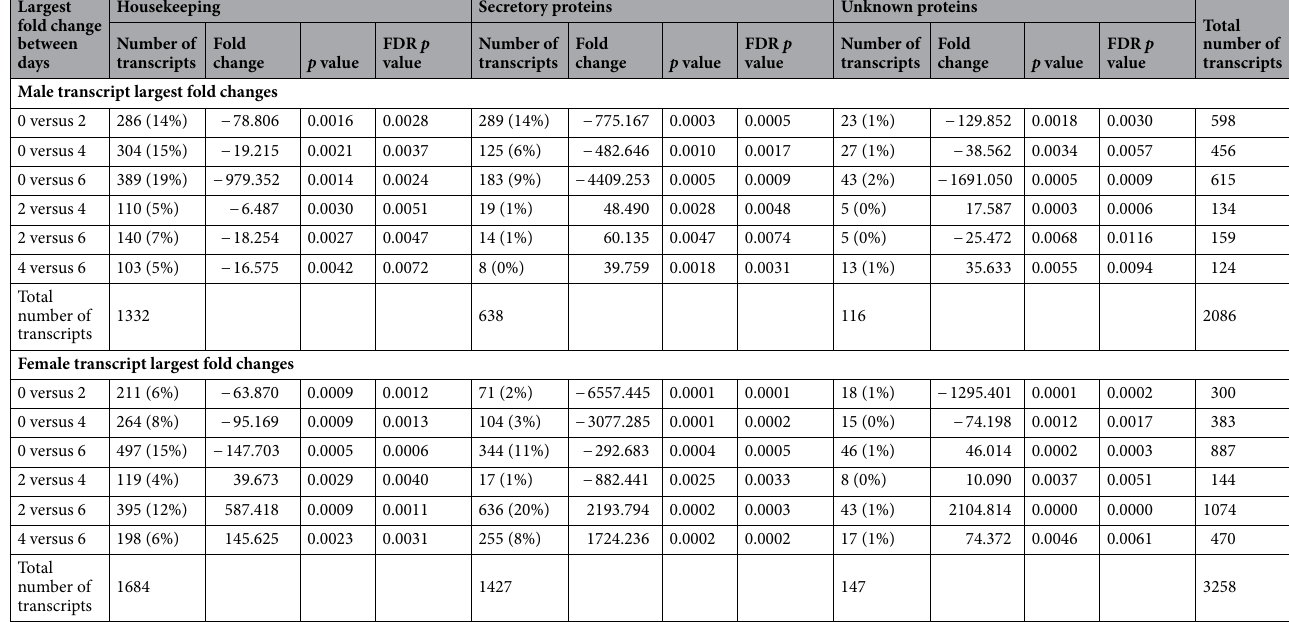
Table 3. Counts of transcripts of each class; housekeeping (HKP), secretory protein (SP) and unknown function proteins (UNK), displaying their largest fold change or mean expression value relative to time points of sampling the female and male salivary gland transcriptome based on differential expression by RNA-Seq analysis using global trimmed mean of M values (TMM) normalization. The percentage contribution to female and male differentially expressed transcripts are indicated in parentheses. The fold-change, p value and false- discovery rate p value (FDR p value) are also indicated as averaged values for the time